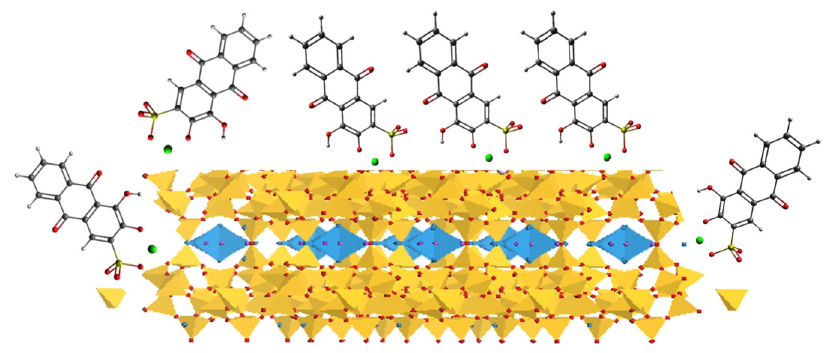
2+ on clinoptilolite